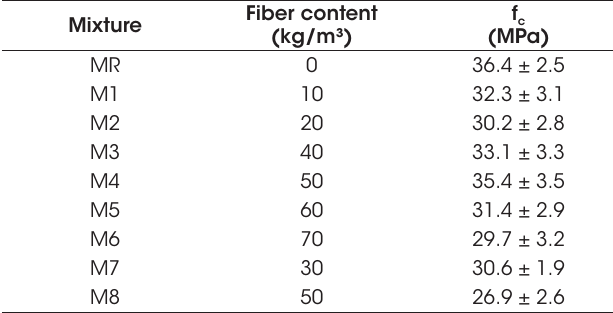
Potential compressive strength of each